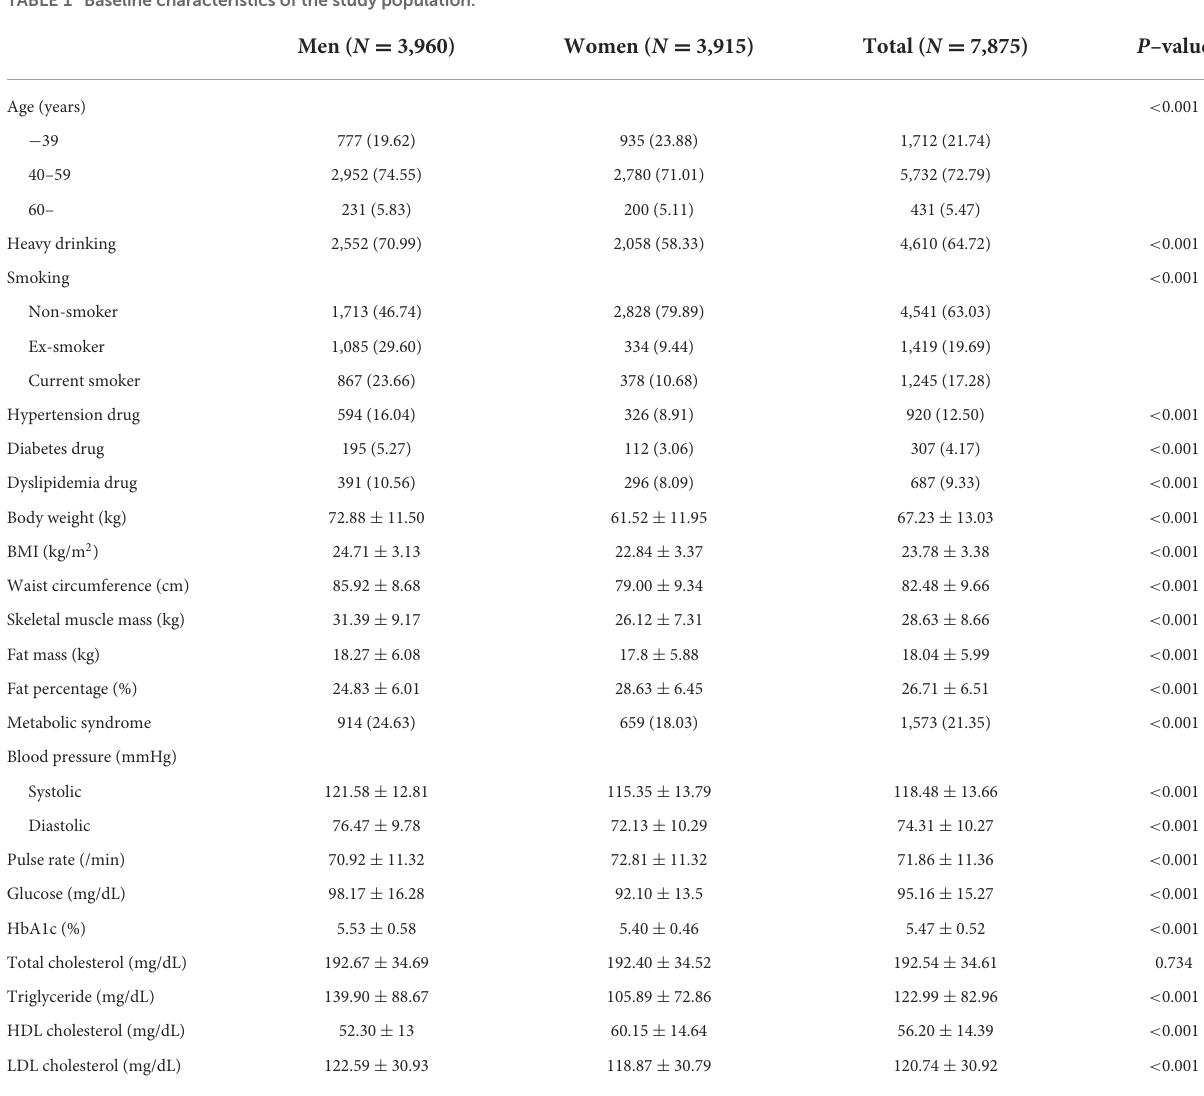
TABLE 1 Baseline characteristics of the study